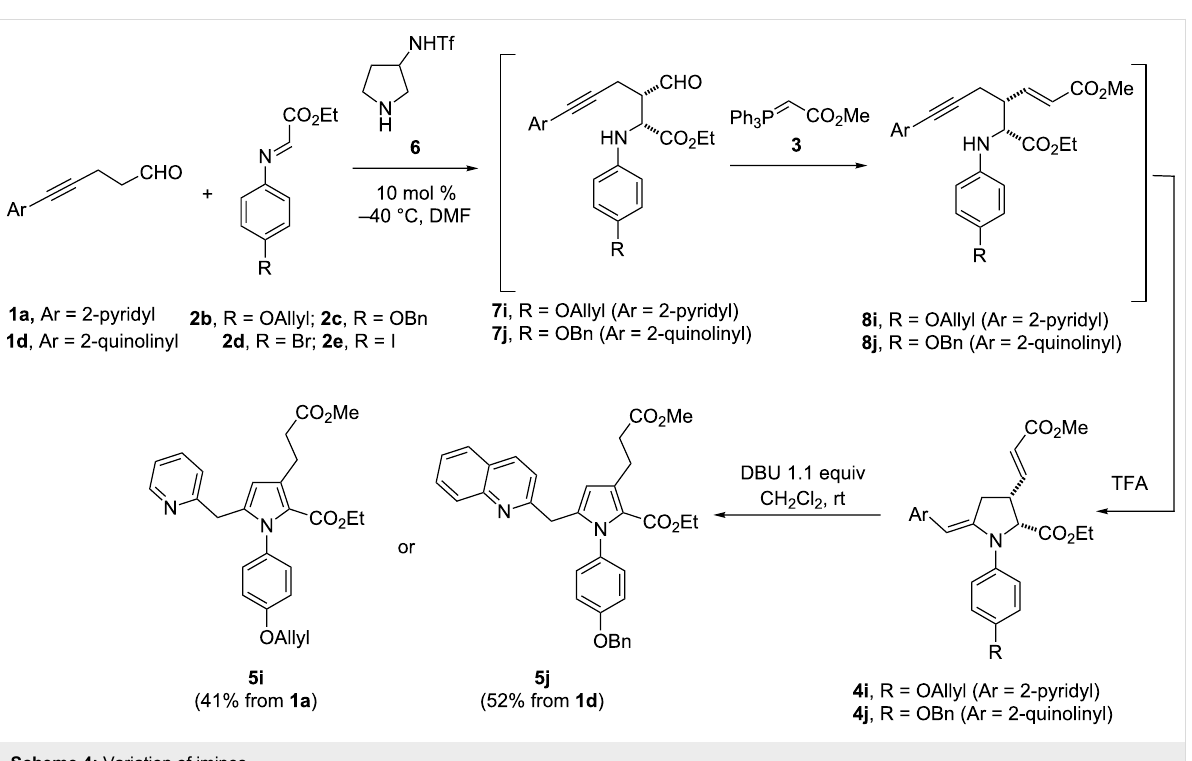
Scheme 4: Variation of